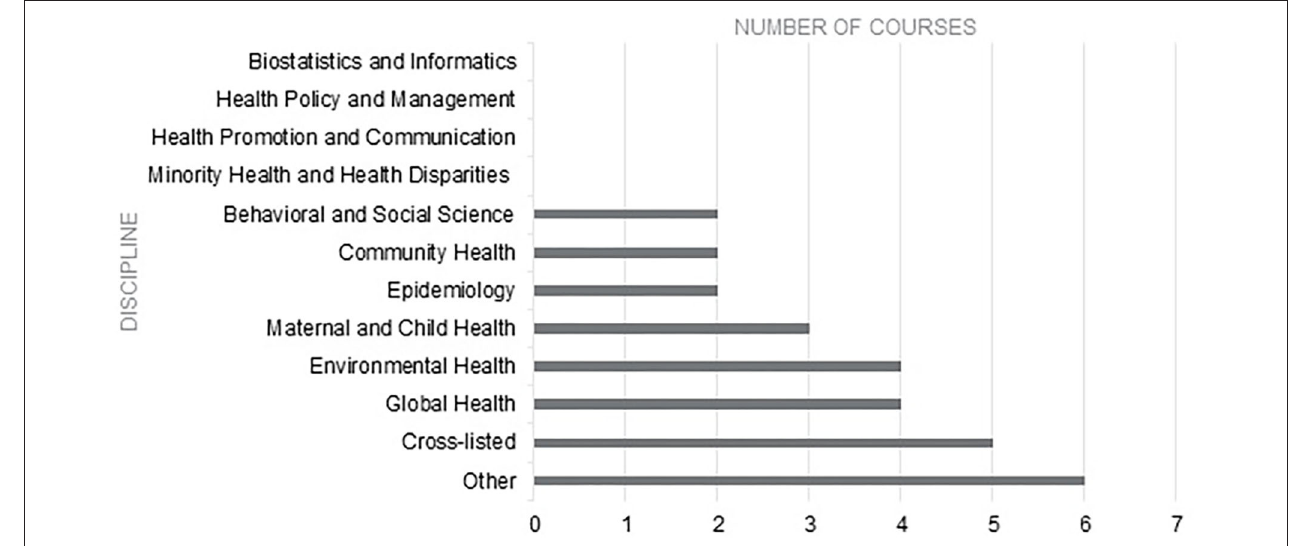
FIGURE 2 | Number of Courses with menstruation related content by